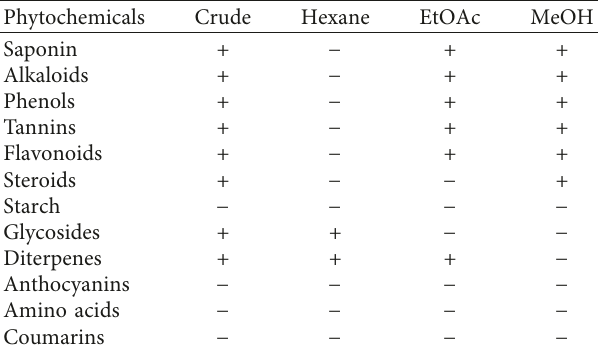
Table 2: Summary of the phytochemical screening test performed on the different